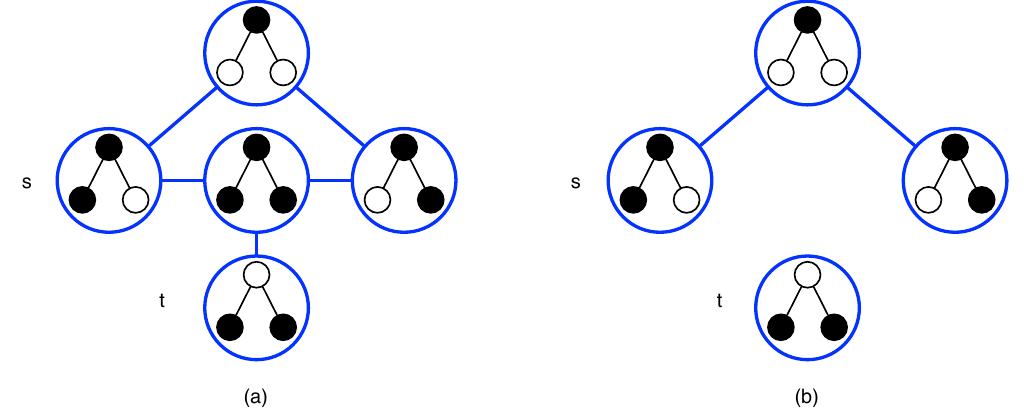
Figure 2. ( a ) V ERTEX C OVER R ECONFIGURATION under TAR with no limit on solution size; ( b ) V ERTEX C OVER R ECONFIGURATION under TAR with solutions of size at most